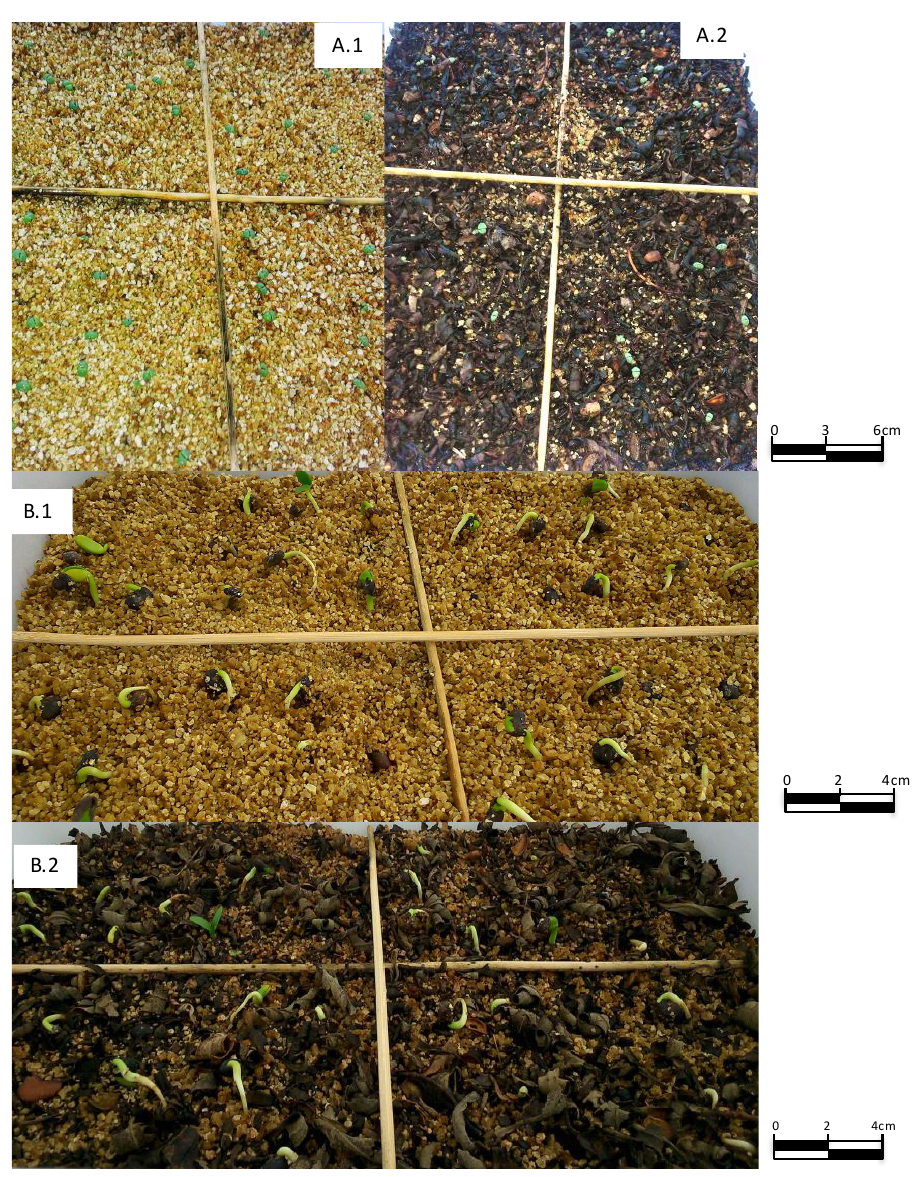
Figure 2. Image of the germination of L. stoechas seeds sown in the control ( A.1 ), and sown in UL2/3 ( A.2 ). This image has been taken 15 days after the seeds were sown. Image of the germination of the R. sphaerocarpa seeds sown in the control (B.1 ), and sown in UL2/3 ( B.2 ). This image has been taken 10 days after the seeds were sown. Control: vermiculite; UL2/3: untreated leaf litter, 0.66 dm 3 of vermiculite and 1.33 dm 3 of leaf